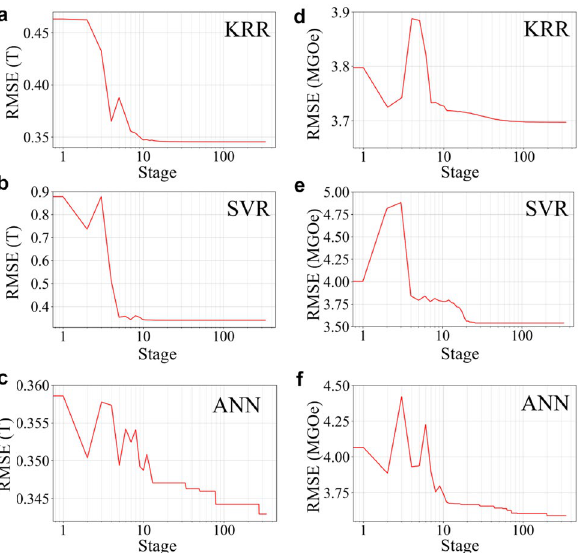
Figure 3. Profiles of RMSE by VFSA coupled with different ML models. The profile of the RMSE between the predicted and actual values of coercivity as optimized with the (a) KRR, (b) SVR, and (c) ANN models and of BH max as optimized with the (d) KRR, (e) SVR, and (f) ANN models indicate two phases: a high degree of randomness at the initial stages (1–10) and a gradual minimization at the latter stages (10–100).